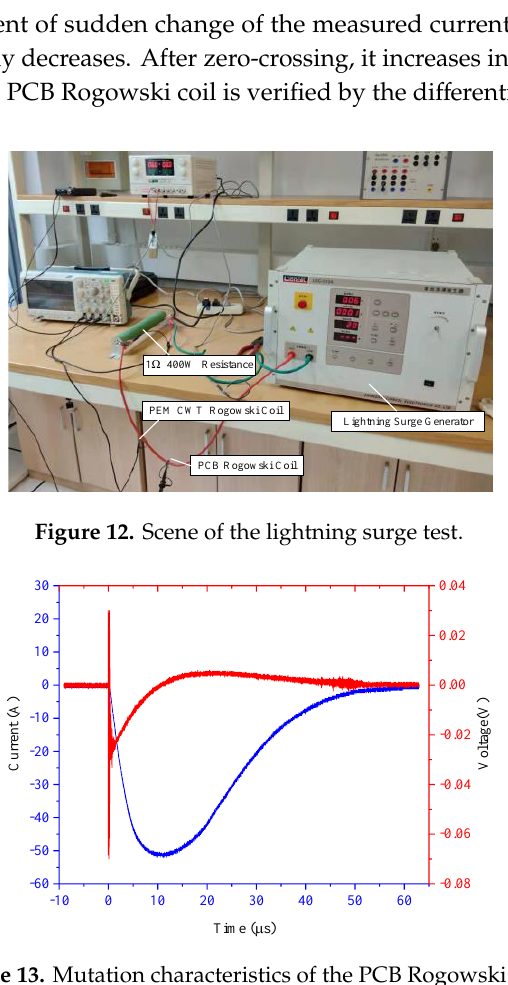
Figure 13. Mutation characteristics of the PCB Rogowski coil.